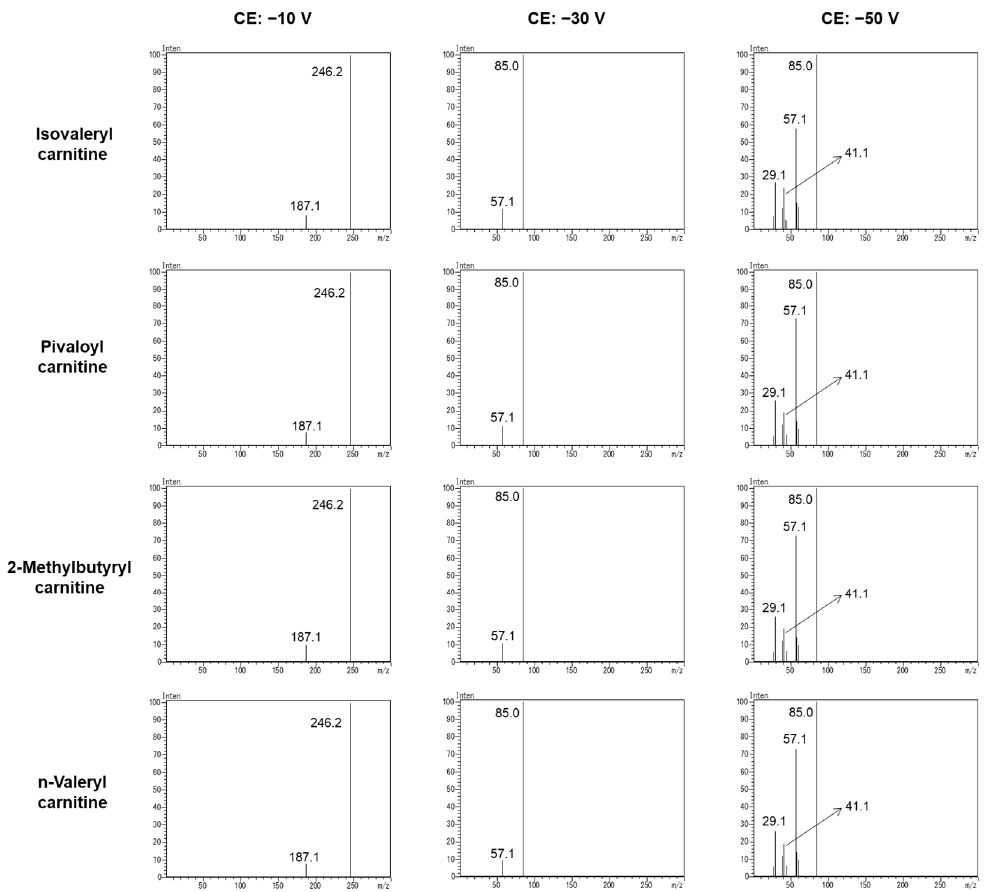
Figure 1. Structure of C5-acylcarnitine isomers.